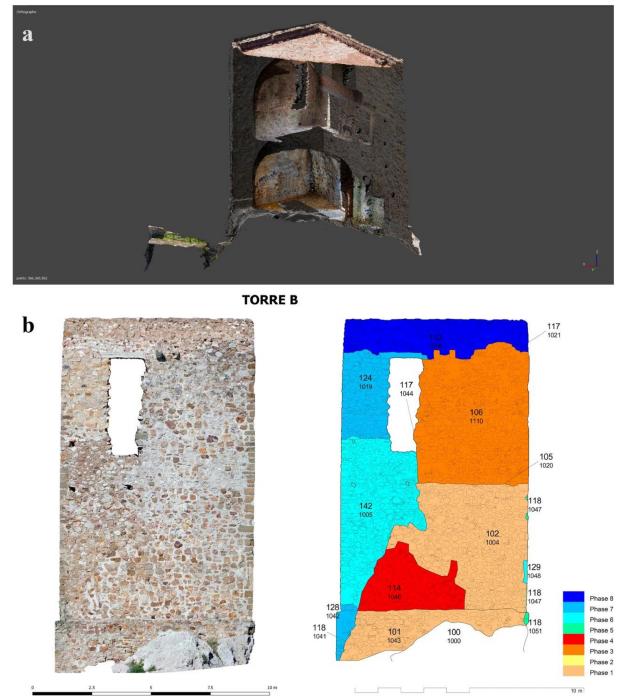
Figure 10. ( a ) Results of ortophotogrammetric acquisitions of the tower of the medieval Castle of Belmez. ( b ) Stratigraphic results. Images from Urbe pro Orbe for “Ager Mellariensis” / AEI FEDER HAR